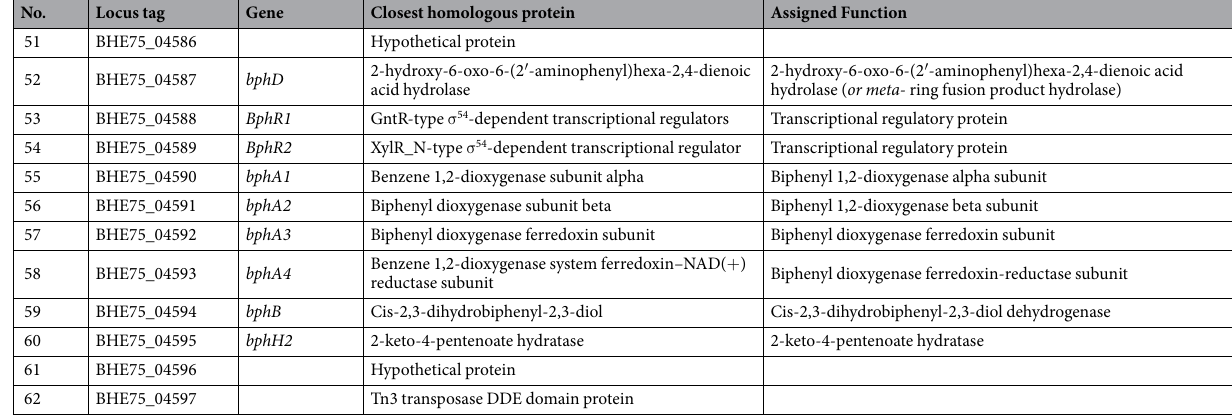
Table 1. A list of the catabolic genes contained in operons 1, 2, 3 and 4 found in the genome of S. haloaromaticamans strain P3. The organization of these genes in the respective operons are presented in Fig.